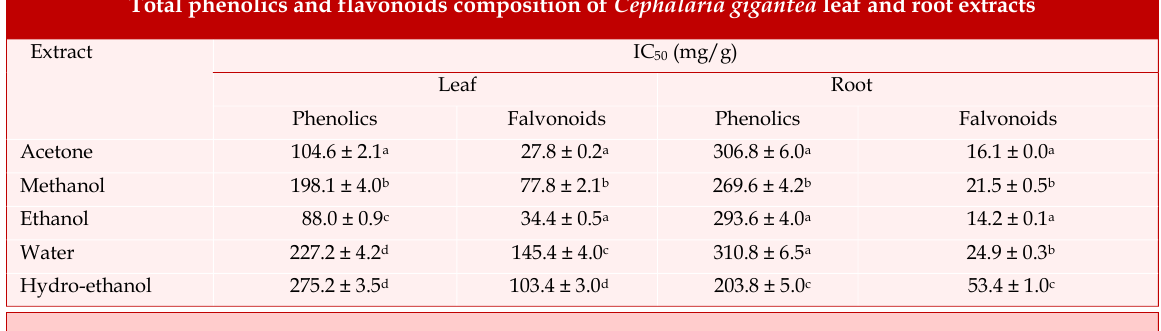
Total phenolics and flavonoids composition of Cephalaria gigantea leaf and root extracts